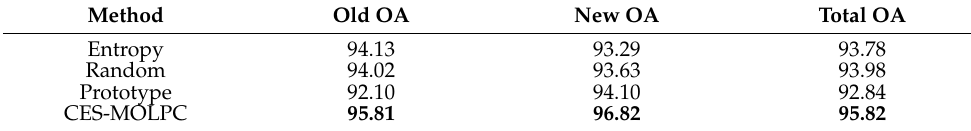
Table 6. Comparison of class exemplar selection methods on the ACARS data set ( T =